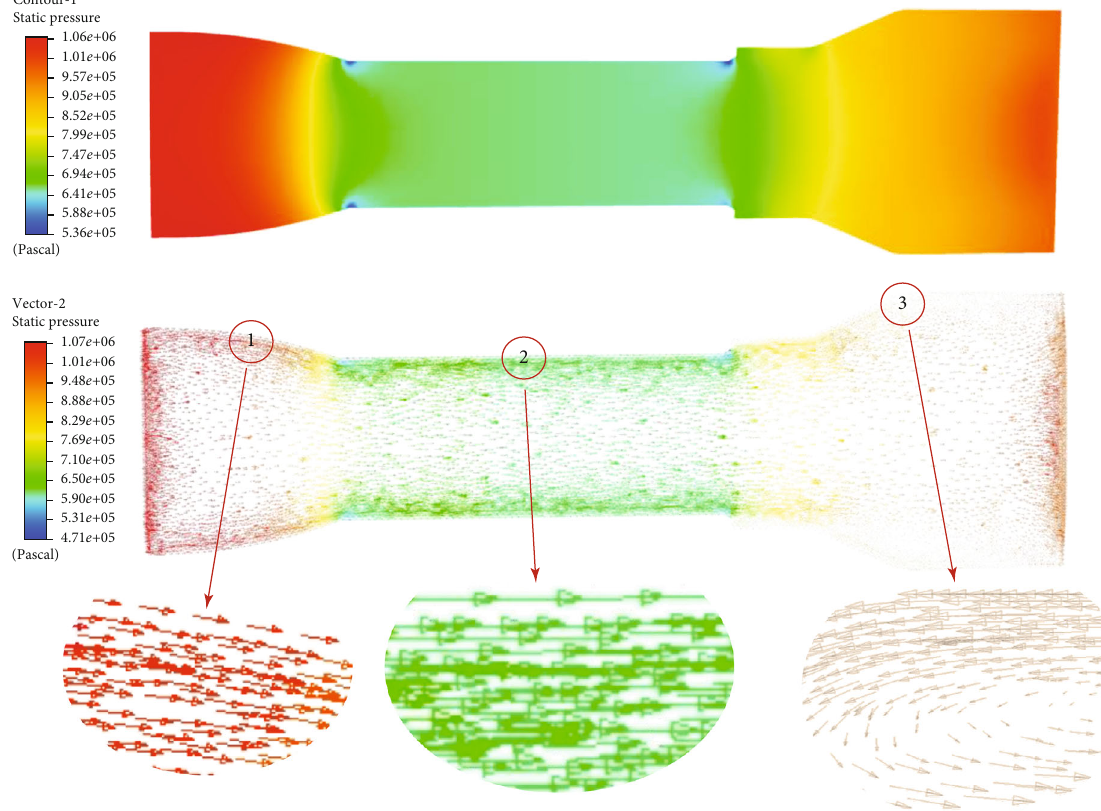
Figure 13: Drilling fl uid pressure cloud diagram and vector diagram on the axis cross section of the coupled